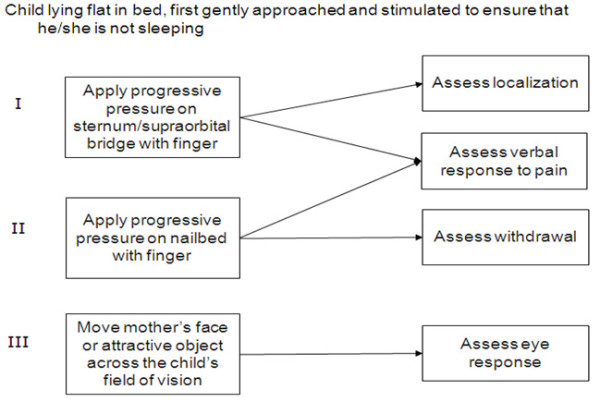
The integrated Blantyre coma scale assessment.